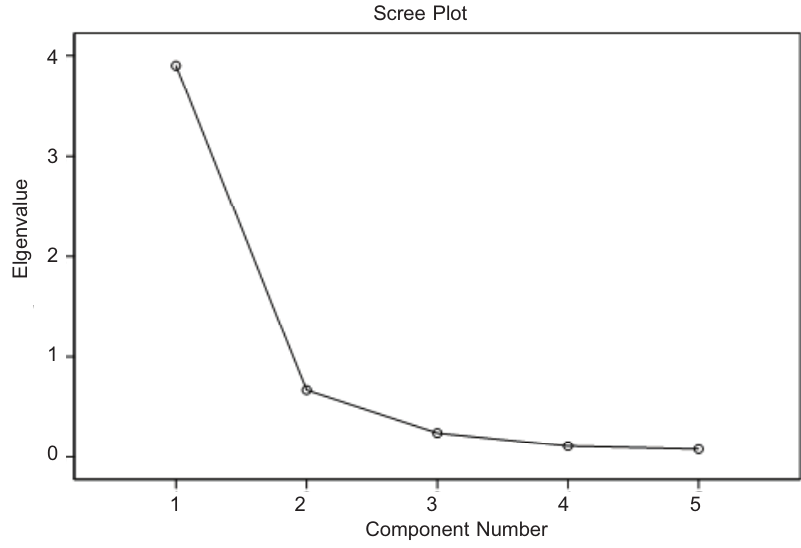
figure 2. Screen plot of variables from the “home” group